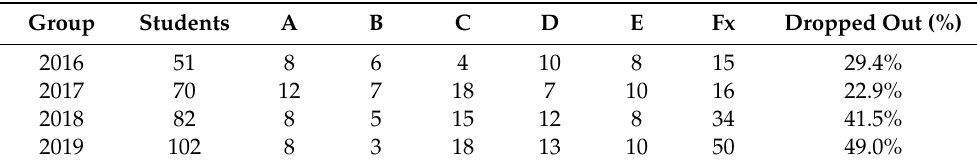
Table 1. Structure of final grades and